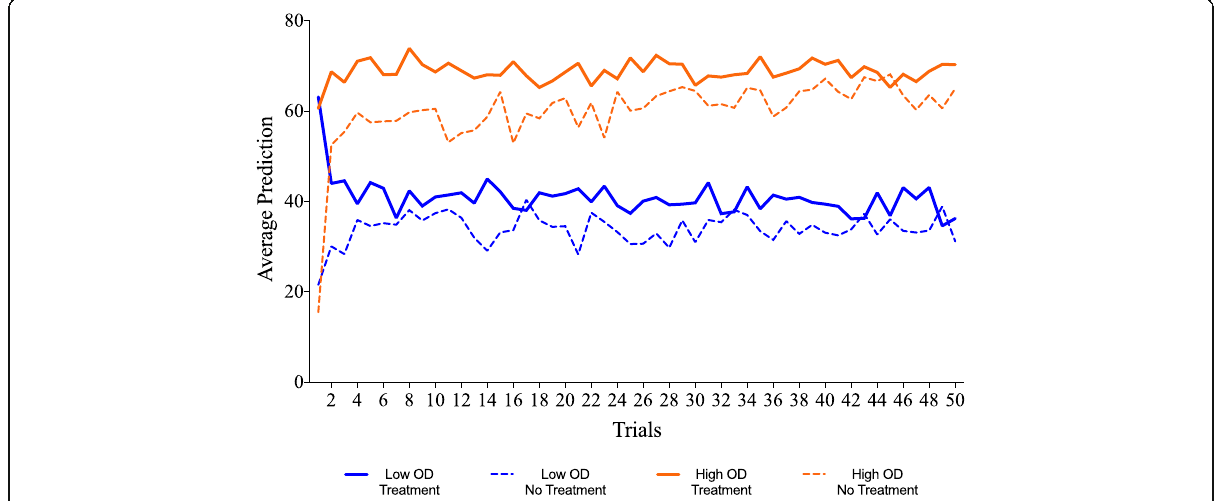
Fig. 6 Average health improvement predictions across trials as a function of OD (low vs. high) and cue type (treatment vs. no treatment) for participants in Experiment 2. OD outcome